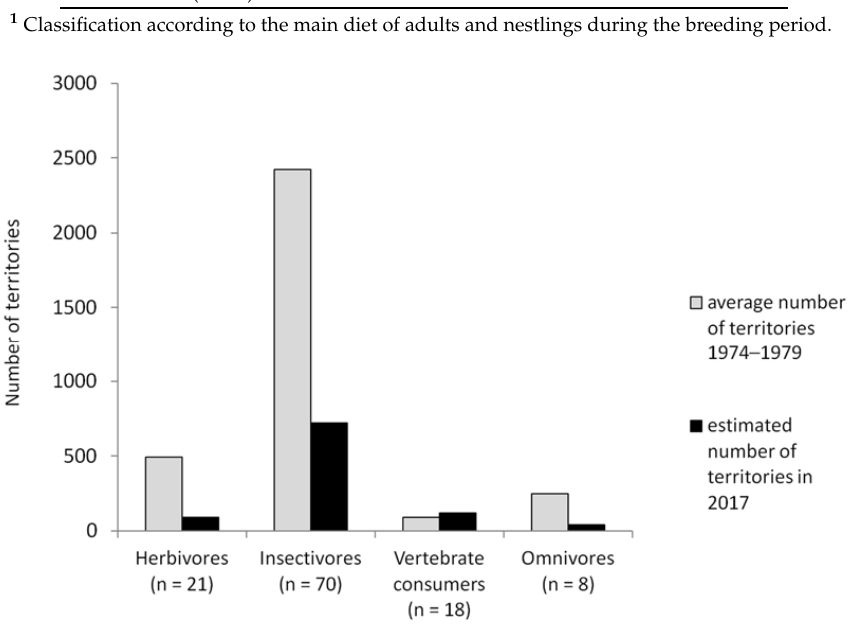
Figure 2. Number of territories across species at “Lampertheimer Altrhein” between 1974 and 1979 (average values) and in 2017 grouped by the main diet of adults and nestlings during the breeding period. The values for 2017 were extrapolated to the size of the study area in 1974–1979.